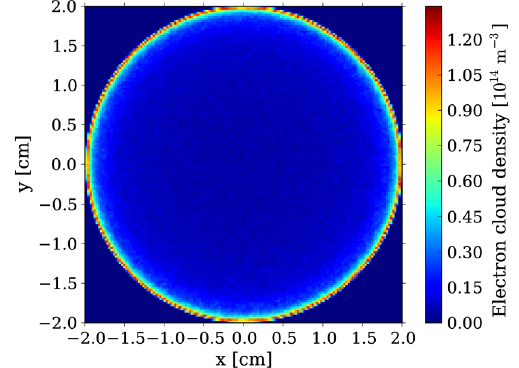
FIG. 2. Snapshot of the electron density of the saturated cloud 6 × σ before the bunch peak (25 ns spacing) in a circular pipe. z